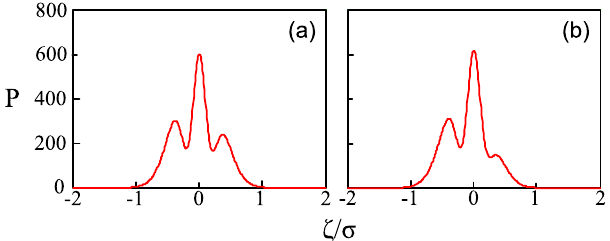
FIG. 6. Pulse shape vs ζ = σ at z ¼ 0 . 85 · L for bunches u centered at ζ ¼ 0 (a). Here the used parameters for the simulation: rms length σ 1 ¼ σ = 2 and σ 2 ¼ σ = 4 ; energy spread 0 . 1 , and μ 0 . 3 ; the packet with lower parameter μ ε ε ; 2 ¼ ; 1 ¼ energy spread and shorter rms length has also slightly larger current densities, leading to Pierce parameter ρ 1 ≅ 1 . 2 × 10 − 3 , ≅ 1 . 24 × 10 − 3 ; slippage length Δ ¼ 0 . 1 · σ and with a fre- ρ 2 quency separation Δ ν ¼ 6 . In (b) we assume that the bunch portion with better characteristic is shifted towards positive ζ values by a small amount δζ ≅ 0 . 05 · σ